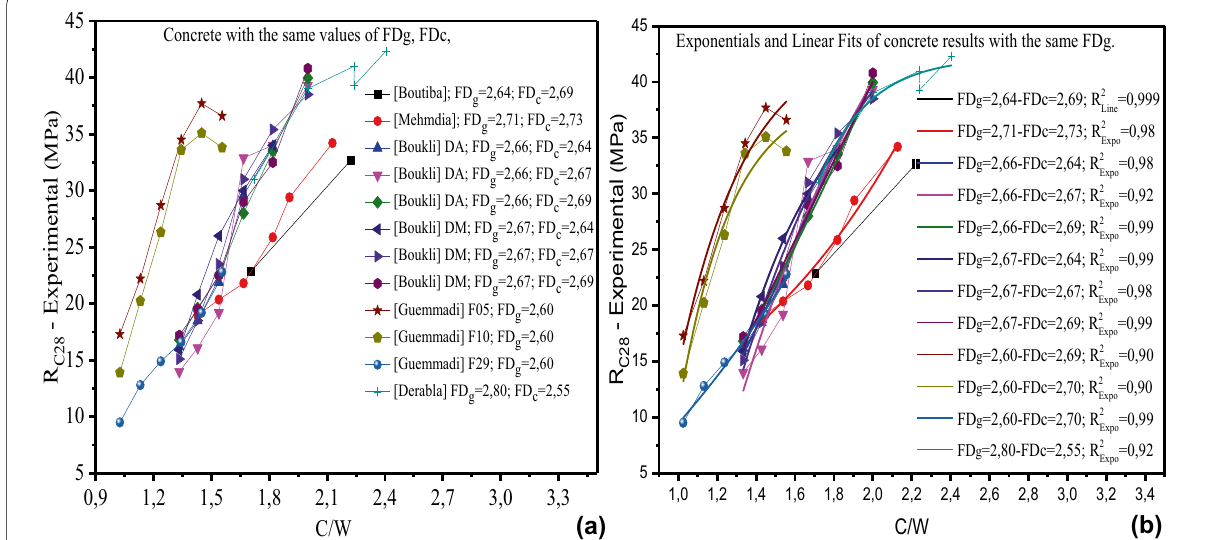
Fig. 11 Effect of the fractal dimension on the evolution of strength R C28 is according to the C / W , ratio. a Result of the effect of FD g ,FD C ; b linear and exponential fit correlations R 2 .